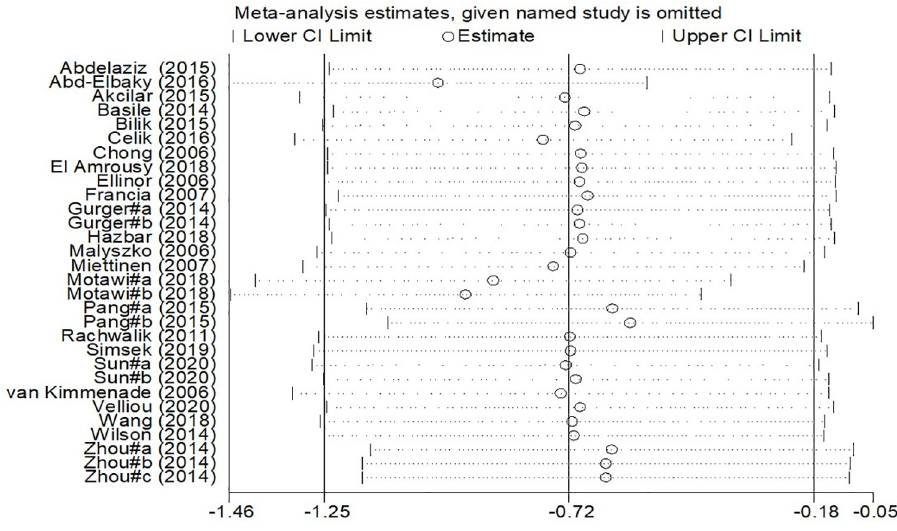
Fig 3. The sensitivity analysis results for standardized mean differences of circulating apelin levels between cases with CVDs and controls.